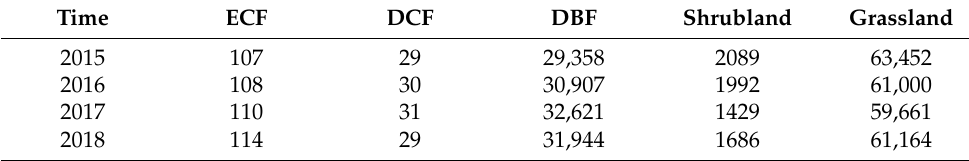
Table 3. Forestland and grassland coverage of each city from 2015 to